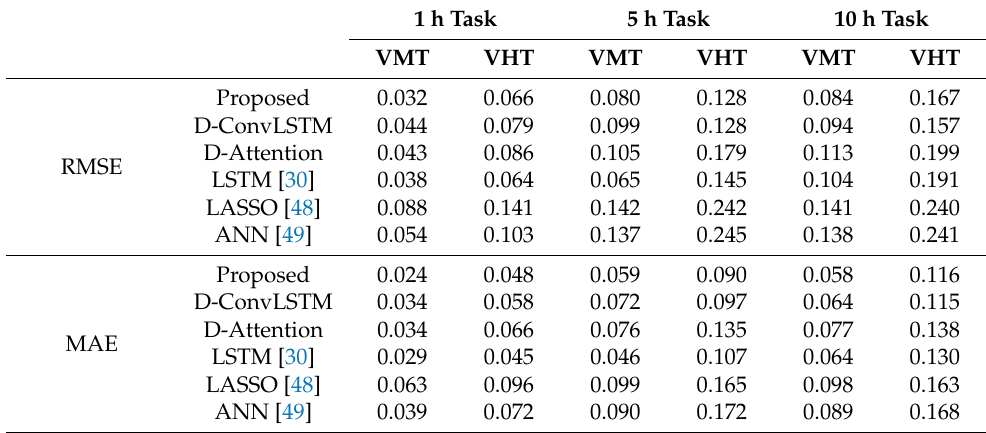
Table 6. The traffic flow prediction errors in terms of RMSE and MAE for the proposed methods and other data-driven methods under the first case.